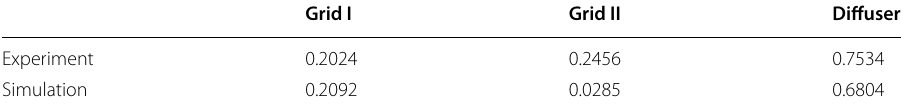
Table 1 SSIM between the recorded pattern and the calculated convolution